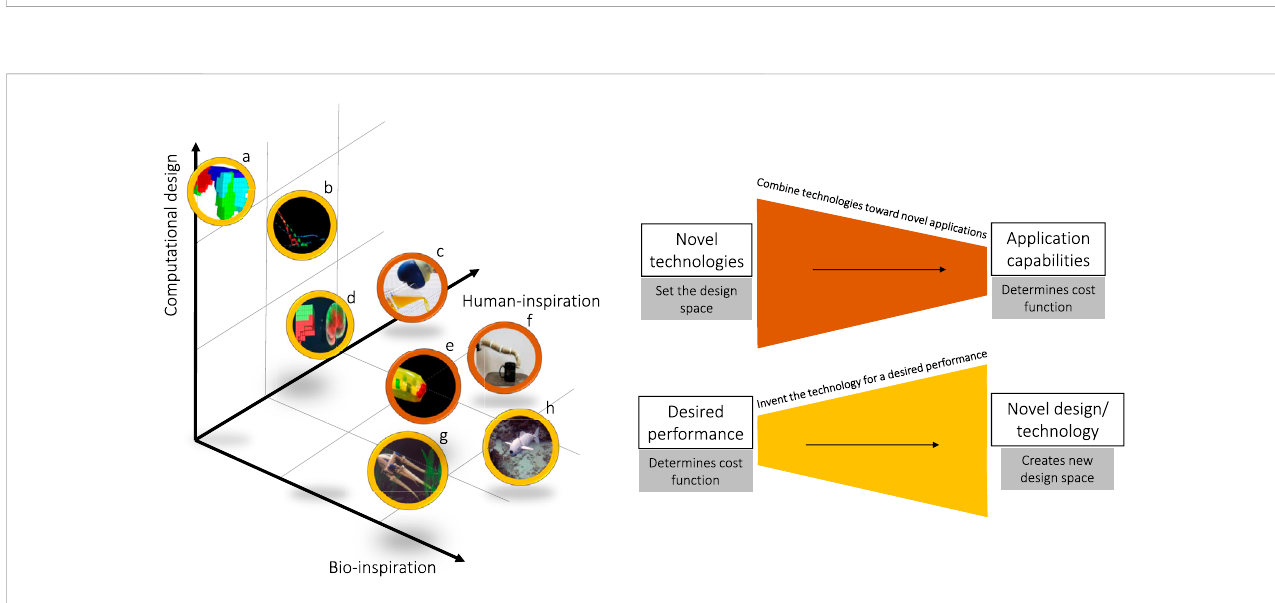
FIGURE 3 Pictorial representation of notable soft robotic design examples. Based on the methodology and process used, the design are placed in a three dimensional space spanning bio-inspired, computational and human-driven methodologies. As a fourth degree of classi fi cation, the color of the border indicates whether the design process was application oriented, — in red - or exploration oriented — in yellow. In the latter, the goal of building a robot with speci fi c capabilities spurs the development of novel technologies with any of the pipelines presented in Figure 2. a-(Cheney et al., 2014), b-(Obayashi etal.,2022b),c-(Amendetal.,2012),d-(Kriegmanetal.,2020),e-(Hawkesetal.,2017),f-(Chengetal.,2012),g-(Obayashietal.,2022a),h-(Katzschmannetal.,